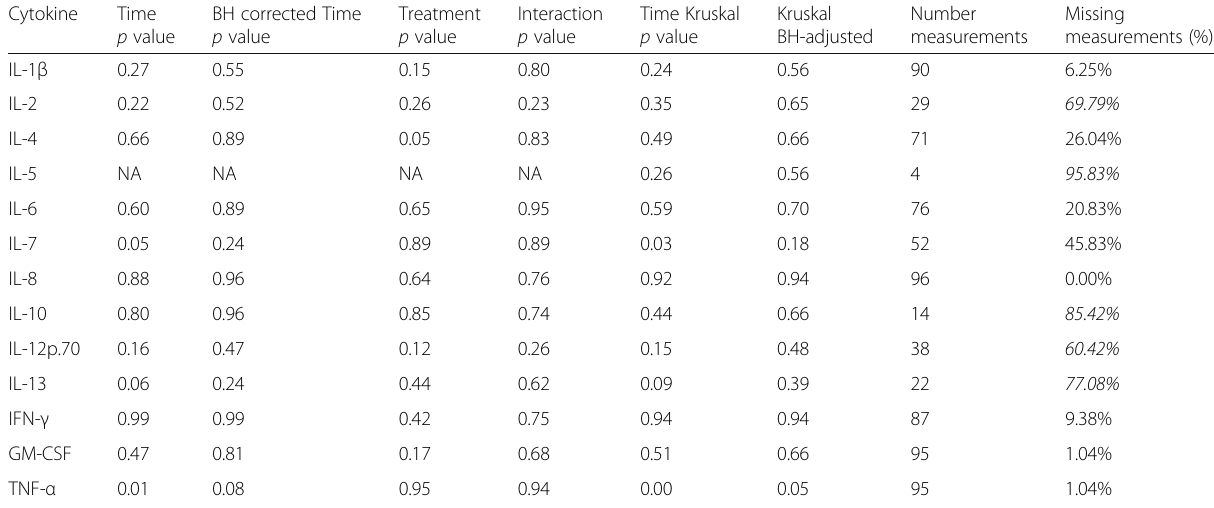
Table 1 Summary of p values from ANOVA analyses with time and treatment factors using the test and control teeth